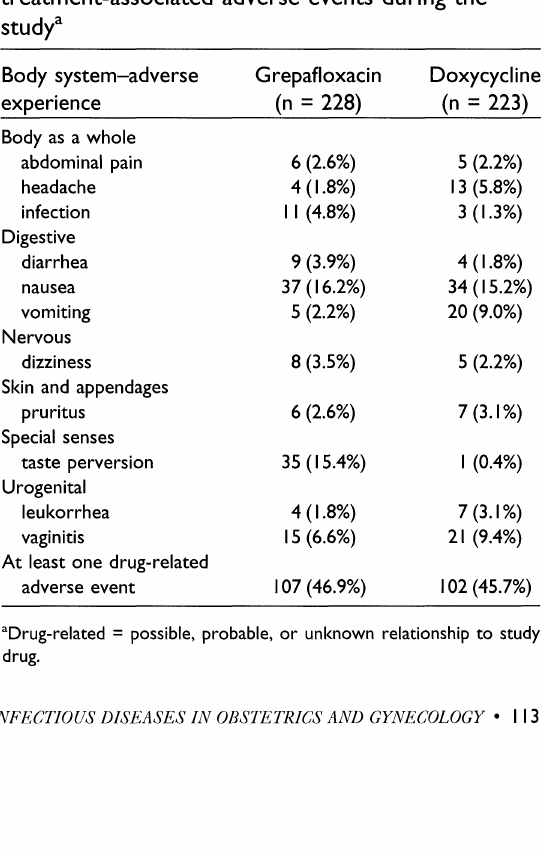
TABLE 5. Most frequently reported